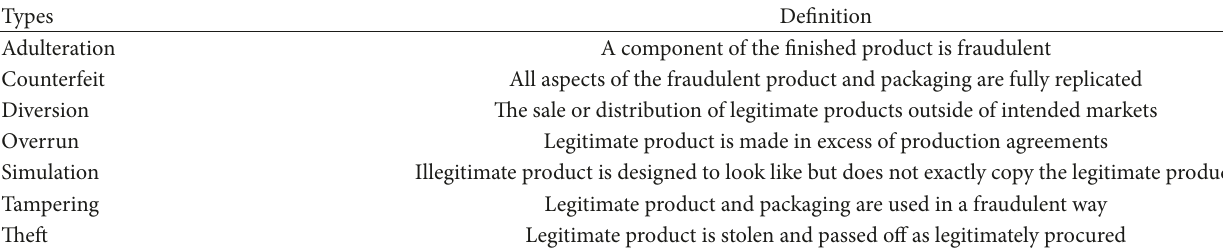
Table 1: Types of food frauds